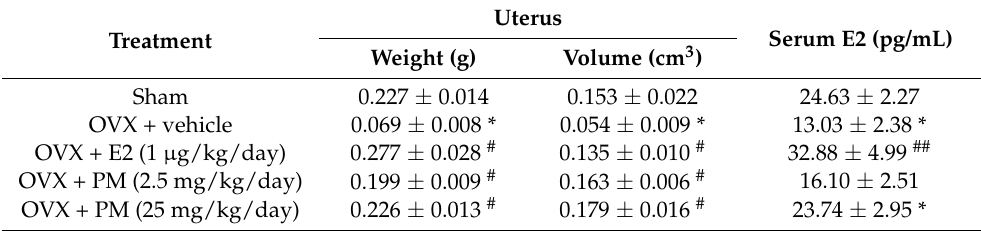
Table 1. The uterus weight and volume and serum 17 β -estradiol levels after the PM treatment. Uterus Serum E2 (pg/mL) Treatment Weight